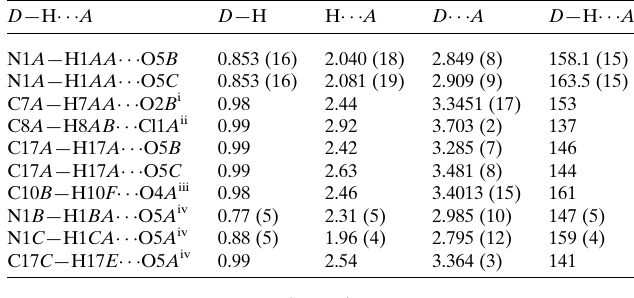
Table 2 Hydrogen-bond geometry (A˚ , (cid:2) ) for 3b .